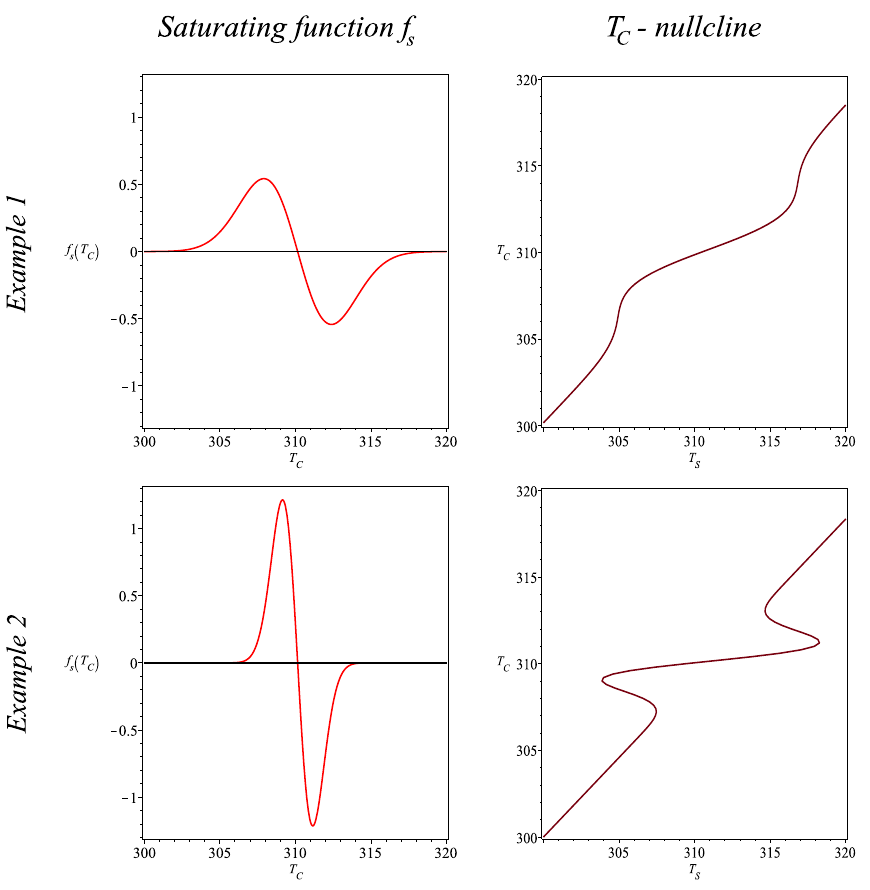
2 min − 1 for parameters v = 0.1 ,